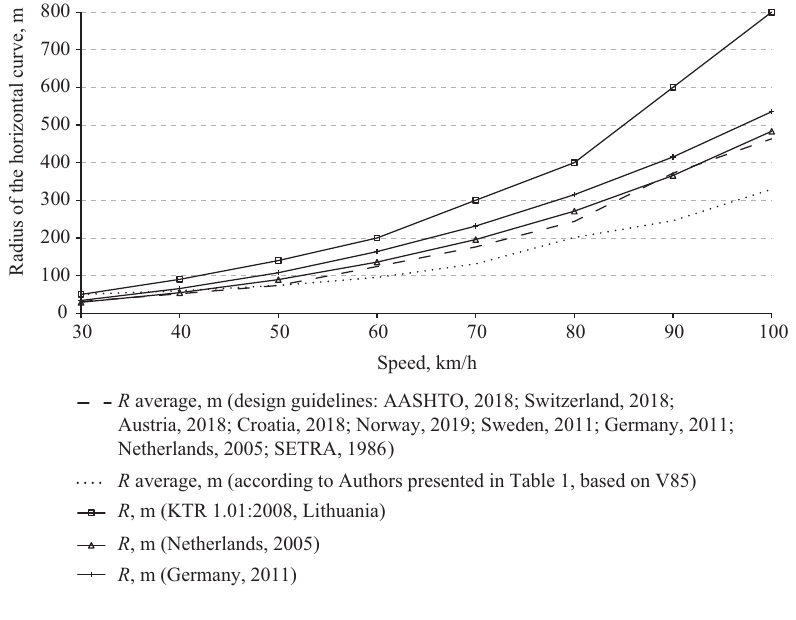
Figure 1. Average of minimum radius of horizontal curve at certain design speed in various countries and average of developed operating speed prediction models by various